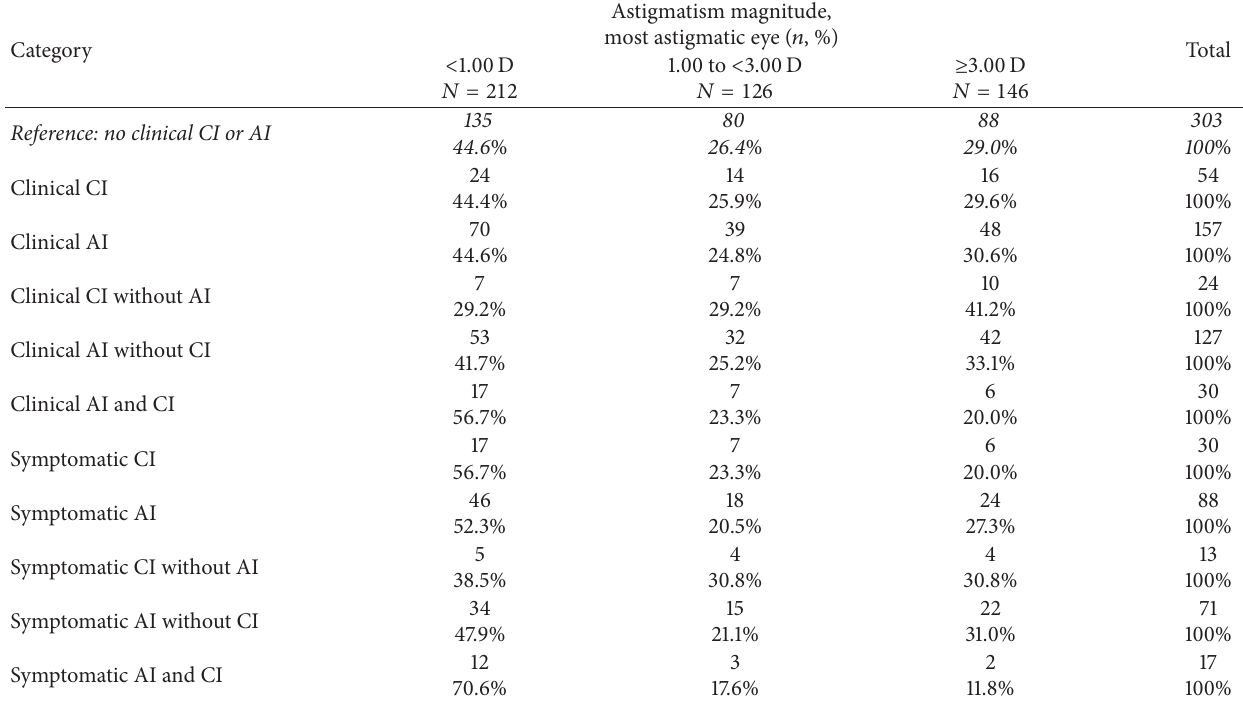
Table 4: Relation between classic/clinical convergence insufficiency (3 clinical criteria met), accommodative insufficiency, and astigmatism magnitude (most astigmatic eye). Chi-square analyses compared each diagnostic category (row) to the reference category: students who did not meet the clinical criteria for either CI or AI (first row of data, in italic). No significant differences were observed (all 𝑝 values >